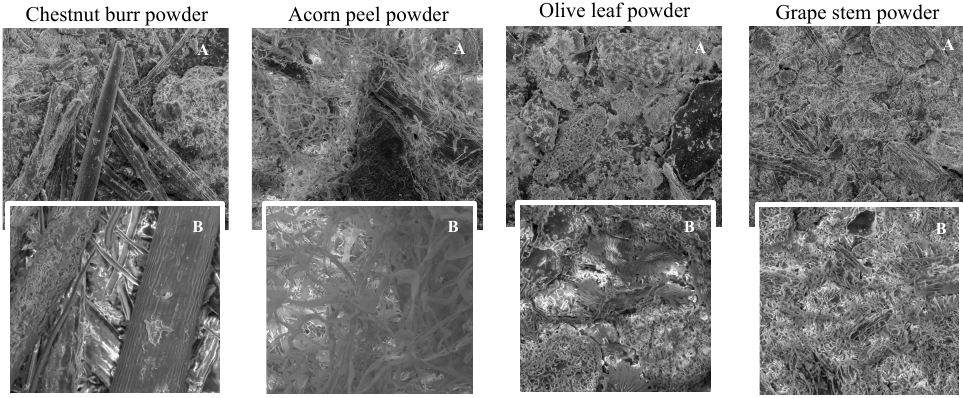
Figure 4. SEM images of each plant-based coagulant identified in the figure ( A )—60× magnification and ( B )—100× magnification.